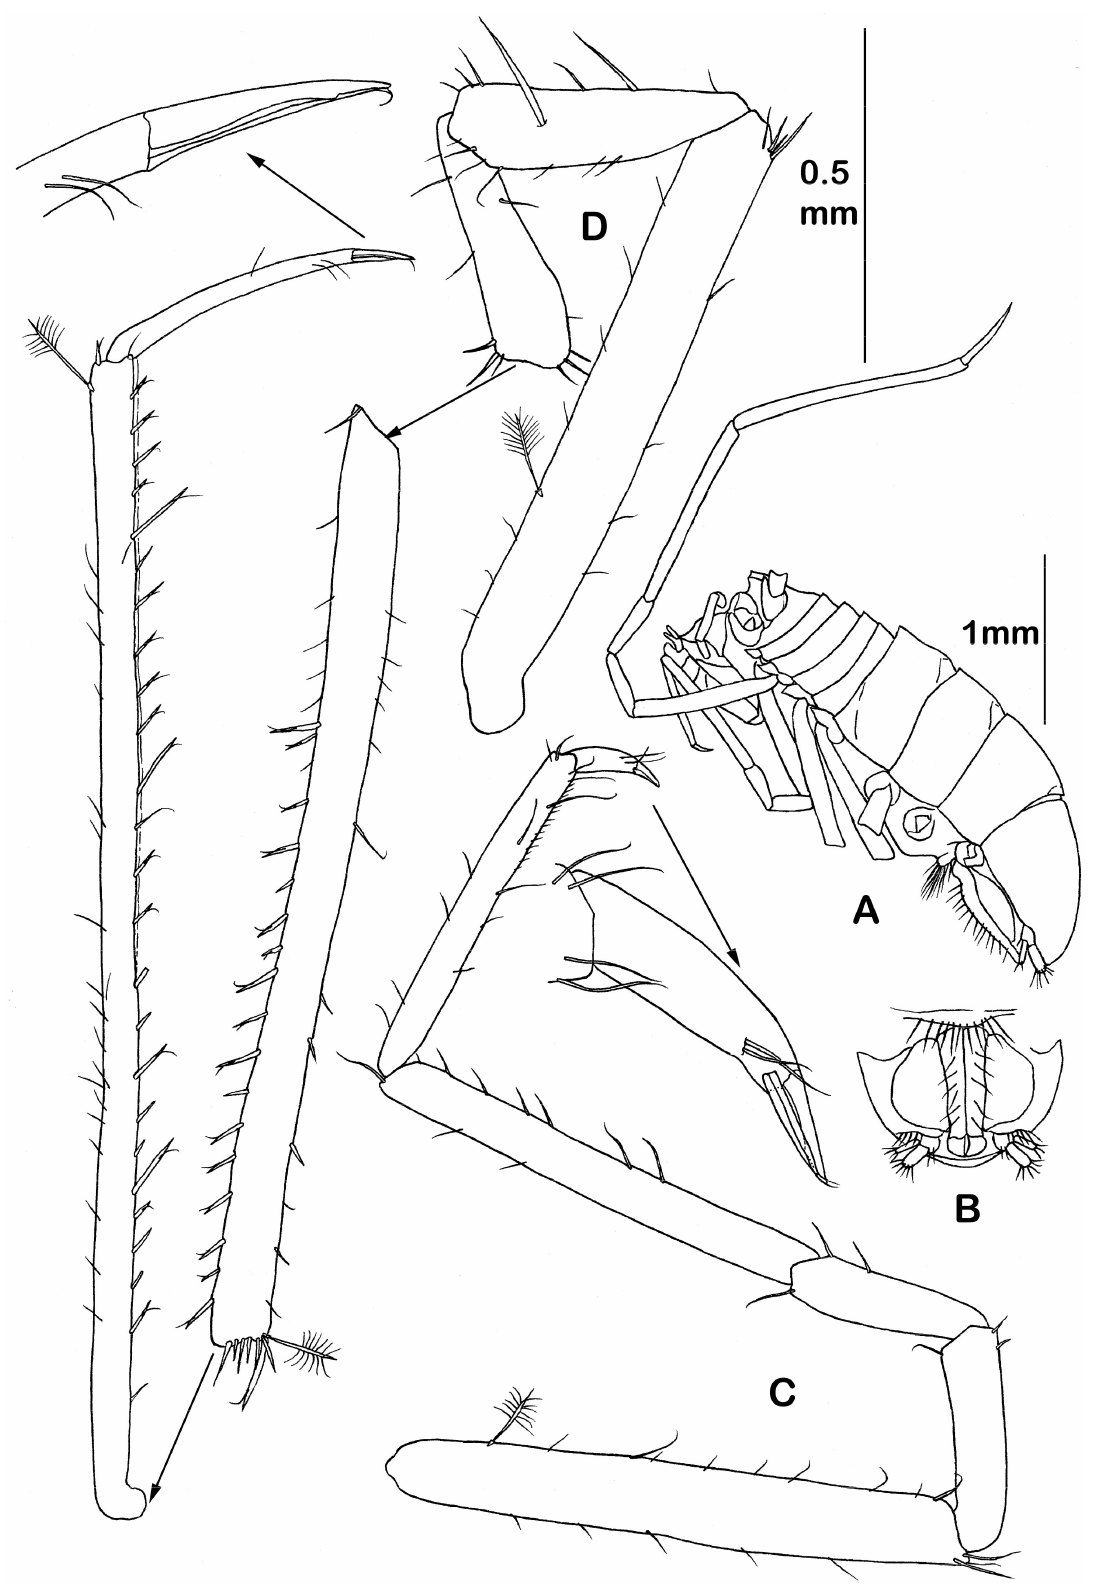
Figure 6. Eurycope producta GO Sars, 1868. Male (ZMH K-45592): ( A ) lateral view; ( B ) pleotelson, ventral view; ( C ) pereopod I (dactylus enlarged); ( D ) pereopod II (dactylus